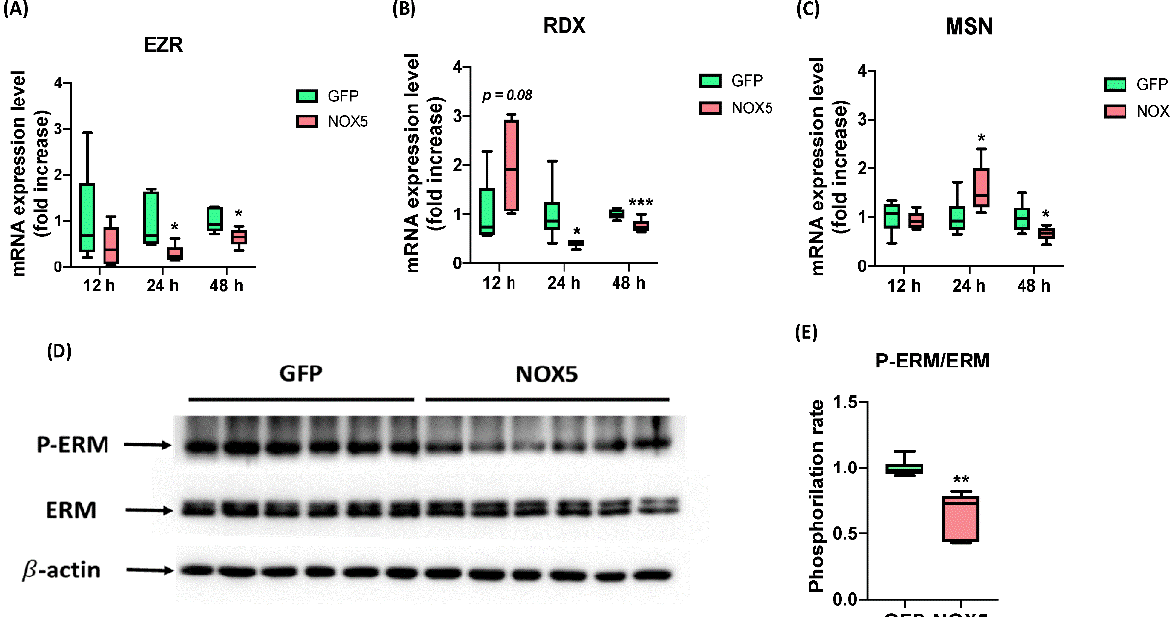
Figure 12. NOX5- β overexpression promotes ERM complex dysregulation and dephosphorylation. ( A ) EZR mRNA expression level after 12, 24, and 48 h of infection ( n = 6). ( B ) MSN mRNA expression level after 12, 24, and 48 h of infection ( n = 6). ( C ) RDX mRNA expression level after 12, 24, and 48 h of infection ( n = 6). ( D ) ERM phosphorylation rate calculated from the previous immunoblot. ( E ) Phosphorylated ERM complex, total ERM complex and β -actin immunoblots after 24 h of infection ( n = 6). EZR: ezrin; RDX: radixin; MSN: moesin; ERM: ezrin-radixin-moesin complex; GFP: GFP- infected hCMEC/D3 cells; NOX5: NOX5- β -infected hCMEC/D3 cells. * p < 0.05 vs. GFP-infected cells, ** p < 0.01 vs. GFP-infected cells, *** p < 0.001 vs. GFP-infected cells. Data presented as mean ± SEM.